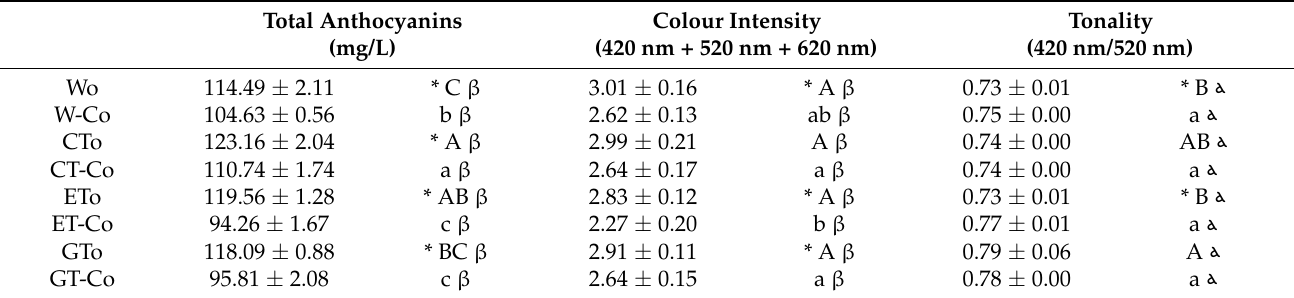
Table 7. Oxidation effect on total anthocyanins, colour intensity, and tonality of treated wines. Total Anthocyanins